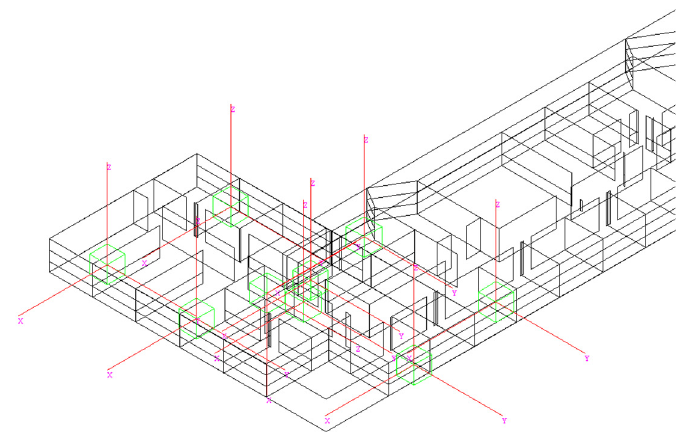
Figure 8. Indoor scenario: A representative section of the University Polytechnic of Madrid